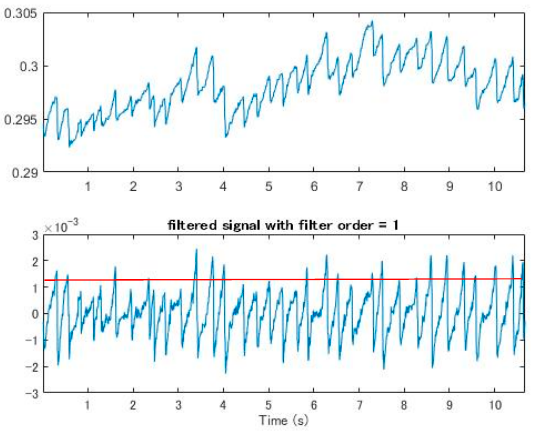
Figure 10. The frequency range selected after filtering. The upper part is the original signal, and the lower part is the signal after the band pass. The red line is the peaks that mark the height of the OKN, which needed to be determined manually and was not accurate.